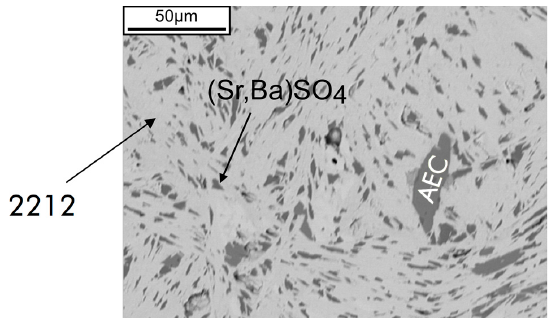
Figure 2. SEM (backscattered electron, BSE) image of a polished cross-section in the central part of the tube showing major second phases (Ba 0.13 Sr 0.87 )SO 4 and (Sr 0.6 Ca 0.4 )CuO 2 (1:1AEC) in the Bi-2212 matrix.